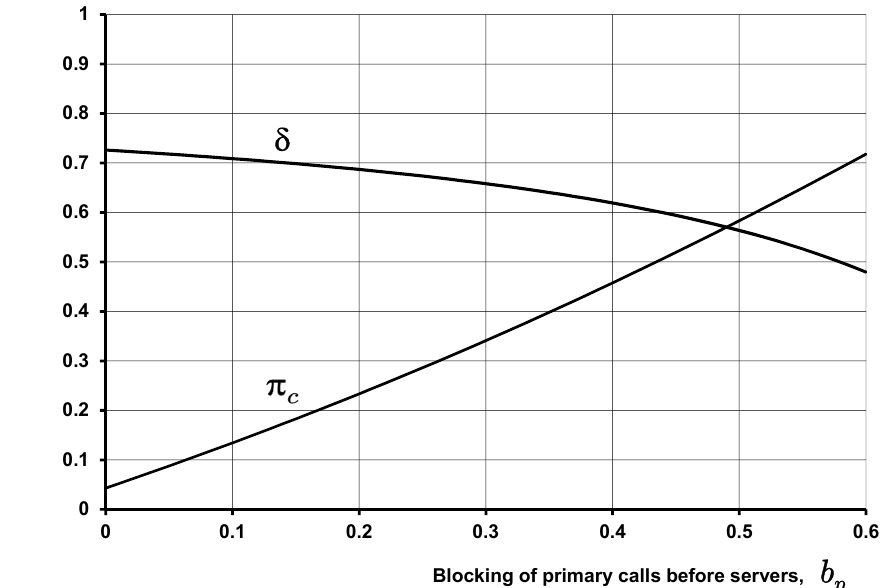
Figure 3. Dependence of π c and δ on b p and b r .